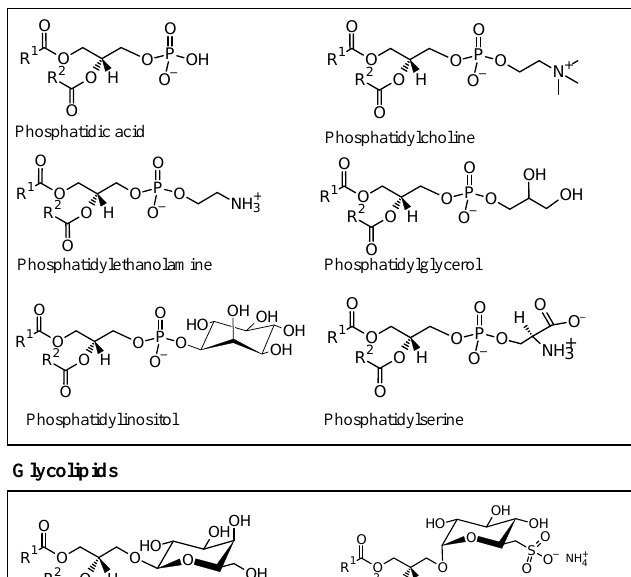
The anti-inflammatory properties of bioactive lipids were evaluated using crude ex- tracts from several microalgae, namely Chlorella vulgaris, Chlorella ovalis, Nannochlorop- sis oculata, Nannochloropsis granulata, Nannochloropsis oceanica, Phaeoductylum tri- cornutum, Amphidinium carterae; the diatoms Odontella mobiliensis, Pseudonitzschia pseudodelicatissima, Coscinodiscus actinocyclus, and Alexandrium minutum; and the mutant microalgae species Tetraselmis sp. (IMP3 and CTP4) or cyanobacteria Arthrospira maxima [19,32,33,50–55]. Different solvents and solvent systems were used to extract the lipids, making an accurate comparison of the results difficult. In these studies, the anti-inflammatory potential was accessed through the evaluation of the release/production of inflammatory mediators, such as the tumor necrosis factor α (TNF- α ) and